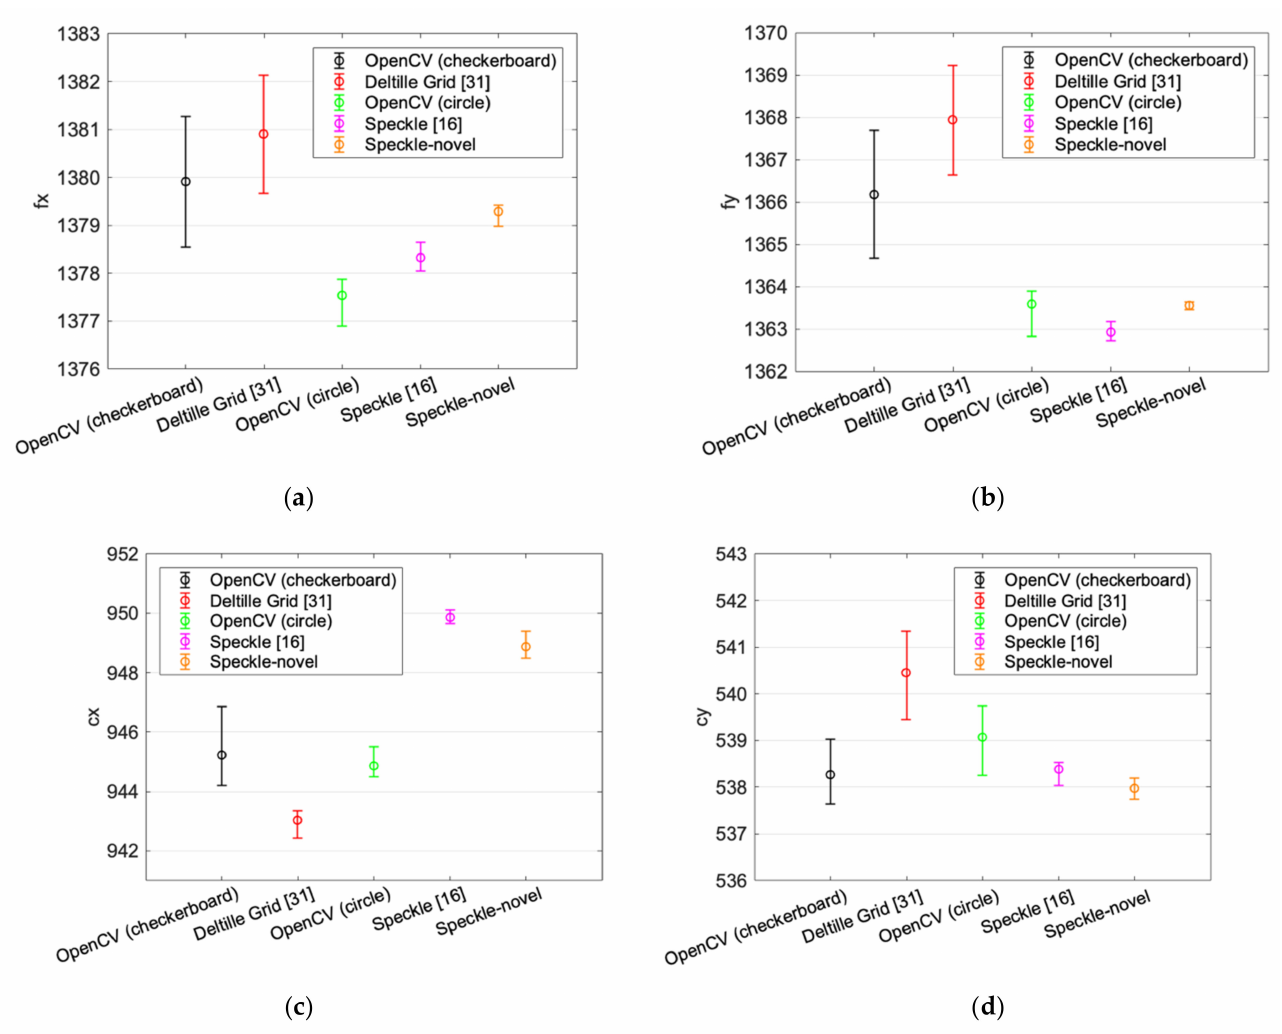
Figure 14. Distributions of internal parameters were estimated using different calibration methods. ( a – d ) are the distribution of estimated fx, fy, cx, and cy,